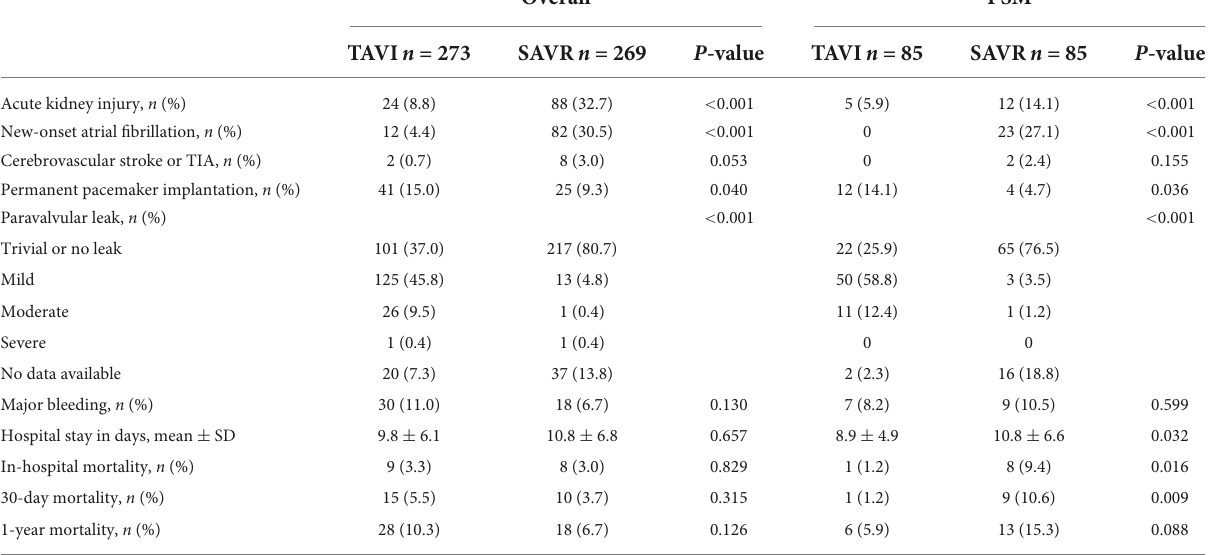
TABLE 3 Clinical outcomes according to TAVI or SAVR.